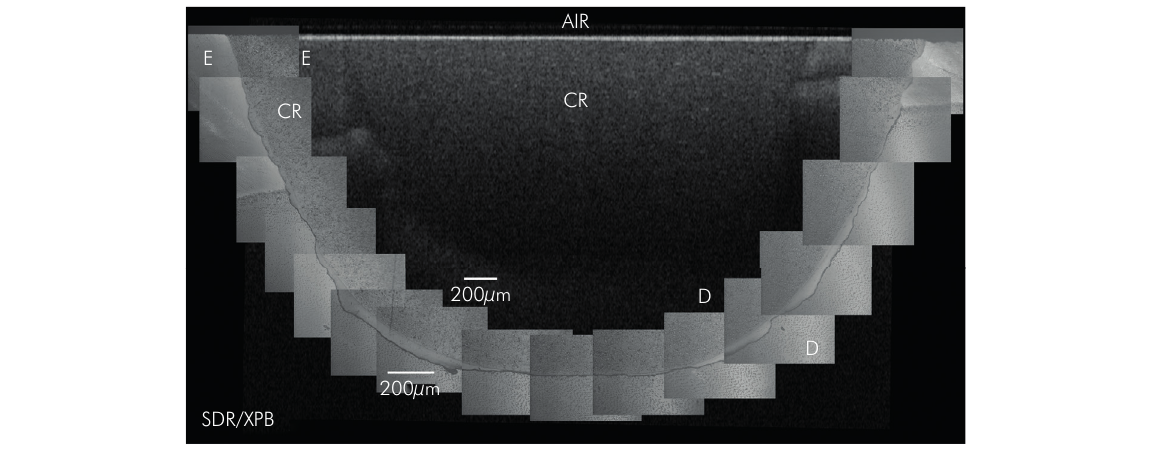
Figure 6. Representative 2D OCT image of SDR/XPB and its corresponding CLSM image. Almost no increase in signal intensity (brighter pixels) were observed at the interface. The OCT and CLSM images indicated a good interfacial